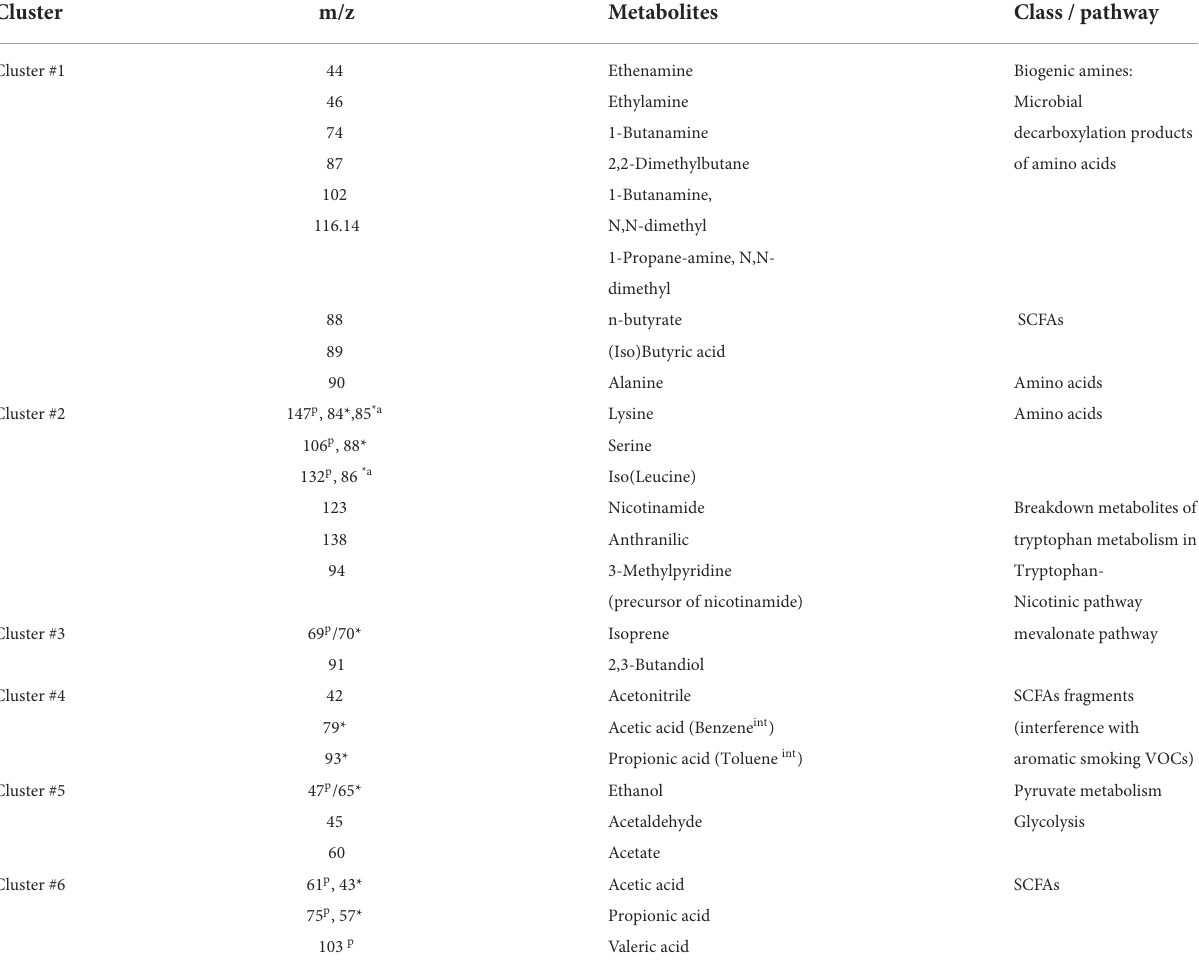
TABLE 3 Clusters of differential breath metabolites with similar responsiveness to awakening stress from baseline to 60min after awakening clustered by HCA and the corresponding primarily dominant chemical class or probable